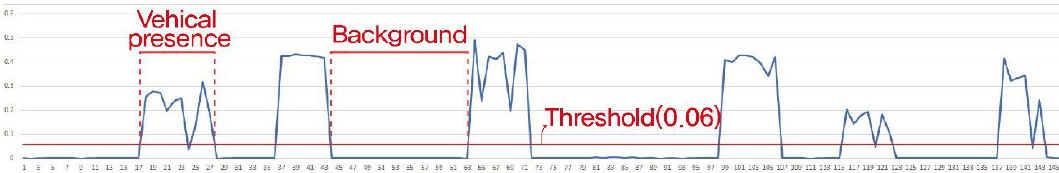
Figure 3. Signal profile from the autoencoder for the test data.